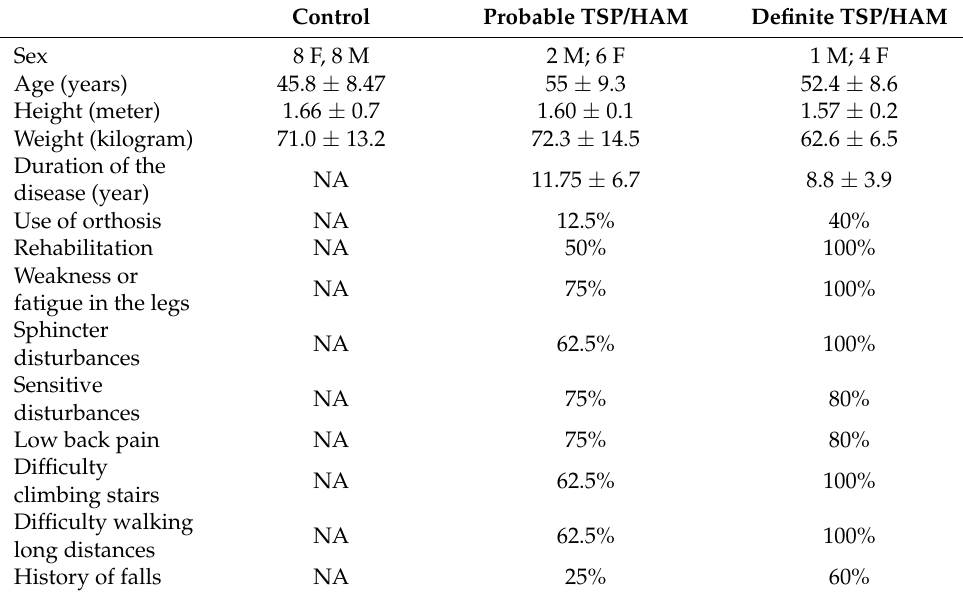
Table 2. Characteristics of the